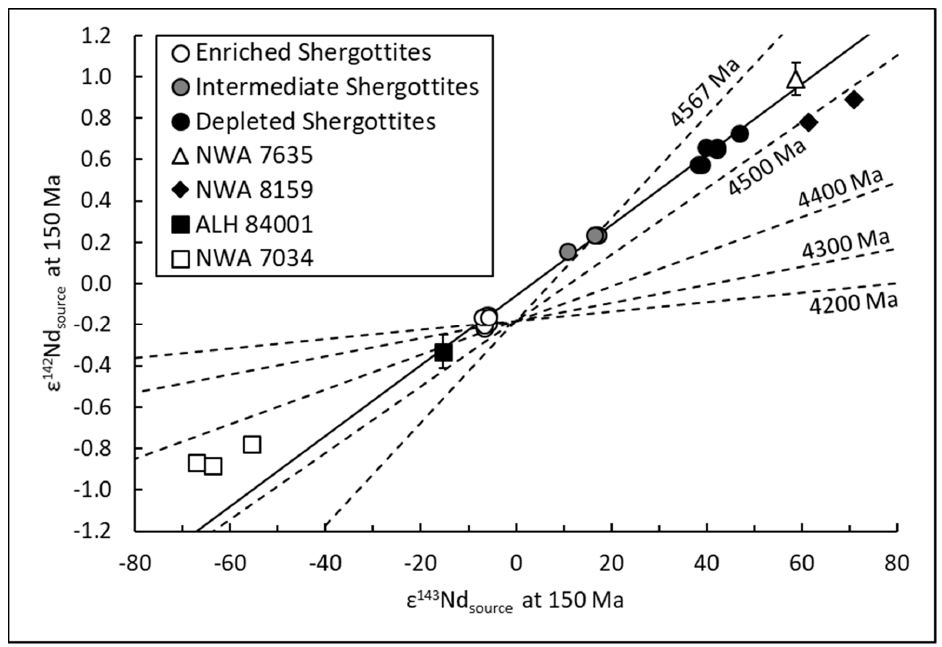
Figure 3. Calculated source ε 142 Nd vs. ε 143 Nd at 150 Ma for Martian meteorites. ε 142 Nd values for ALH 84001 and the Martian regolith breccia sources are corrected for radiogenic growth of 142 Nd. Solid black line is the shergottite source regression line (SSRL) whose slope reflects the age of shergottite source differentiation (4506 ± 6 Ma [87]). Dotted lines are model age isochrons which pass through the chondritic ε 142 Nd value of -0.18 [15]. Since the SSRL does not intersect the model age origin, either it is not an isochron, or Mars’ initial 142 Nd composition was not chondritic [87]. The source of Martian regolith breccia does not intersect the SSRL, suggesting that the shergottite differentiation event was not a planet-wide event such as crystallization and overturn of a magma ocean. Data and models are from refs. [80,87] and references within. Errors are plotted when symbol is smaller than error. The extinct 182 Hf- 182 W chronometer, which has a half-life of 9 Ma, has been coupled with the 142 Nd/ 144 Nd system to refine the time scale of magmatic source differentiation [16]. The combined 182 W- 143 Nd chronometer showed that instead of forming a binary contemporaneous mixing line between depleted and enriched shergottite sources, the shergottite source differentiation was instead spread between ~20–25 and ~40 m.y. after solar system formation (Figure 4) [16]. This was due primarily to a larger range in ε 182 W identified among depleted shergottites (+0.8 to +1.8). 142 Nd measurements of NWA 7034 and ALH 84001 also showed that these samples reflected the most enriched and early to differentiate (~20–25 Ma) source reservoir yet identified on Mars [16]. The early differentiation of an enriched source coincides with modeling results obtained from U-Pb and Lu-Hf analyses performed on zircons in NWA 7034, which required an andesitic, rather than basaltic, crustal reservoir to differentiate from CHUR in order to satisfy the 176 Lu/ 177 Hf values of concordant zircons [22]. The U-Pb ages of these zircons converged at 4475 Ma, while their Lu-Hf systematics suggested that an andesitic crust must have formed no later than 4547 Ma. This early crust was completely reworked by impacts, including the one likely to be responsible for the formation of the Martian crustal dichotomy [90].